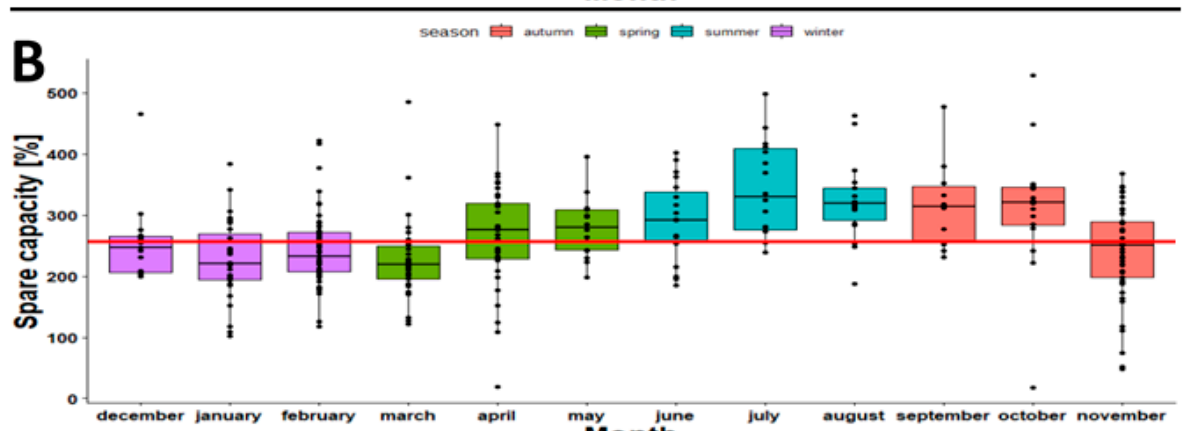
Table 5. Mean, standard deviation and Cohen’s d of all relevant parameters after comparing warm and cold periods of the year in Opti- and Robo-isolated PBMCs. CSA Parameters